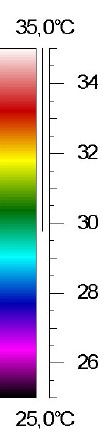
FIGURE 3 – Colors’ scale used in the research